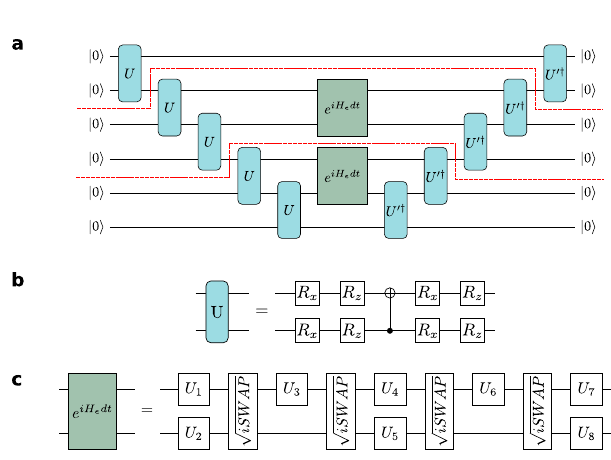
Fig. 4 | Time-evolution circuits. a Time-evolution circuit: The probability of measuring ∣ 0 i (cid:4) N at the output, after post-selecting on the top two qubits on the right-hand side, gives an approximation to λ 2 — the square of the principal eigen- valueofthetransfermatrix(indicatedbythedashedredlines).Thiscircuitprovides a cost function whose optimisation over U 0 gives the state at time t + dt after starting at time t with the state parametrised by U . b Factorisation of the MPS and Time-evolution unitaries: The unitary U describing the iMPS quantum state of the system is parametrised on the circuit as shown. This is reduced from the full parametrisationofatwoqubitunitaryinordertoenableshallowercircuits.Thereis anadditionalredundancyofthe fi rst z -rotationonthereferencequbitstate ∣ 0 i and two further angles contained in the parametrisation do not change through the dynamical quantum phase transition that we study. c Factorisation of the time- evolution unitary: The two-site time-evolution unitary is factorised to the Rainbow gate set asshown.Thisisone of the morecostlypartsofthesimulationintermsof